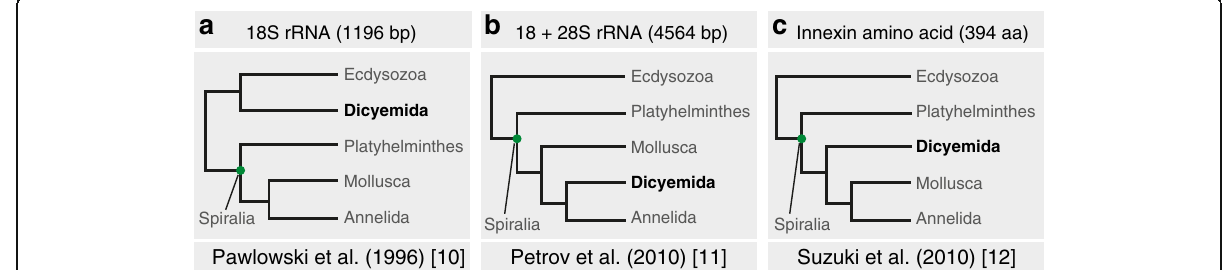
Fig. 2 The phylogenetic position of dicyemids suggested by previous phylogenetic studies remains controversial. a Phylogenetic trees inferred from 18S rRNA sequences, ( b ) 18 + 28S rRNA sequences, and ( c ) innexin amino acid